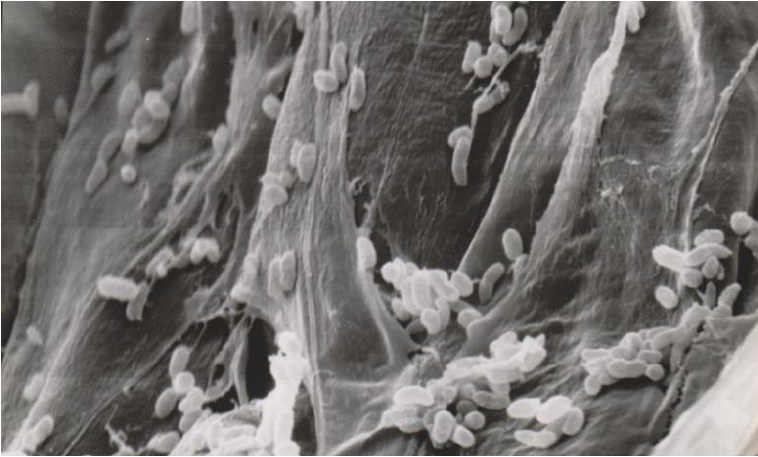
Figure 5. Bacterial cells colonize dead plant tissue (scanning electron microscope photo, 2620× magnification).